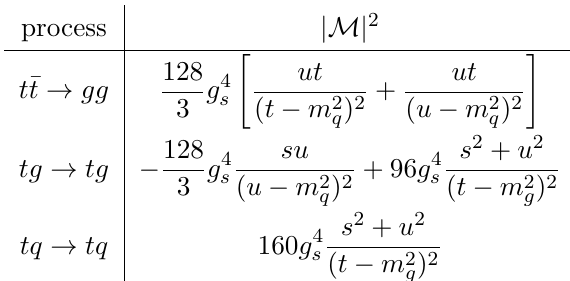
Table 1 . Amplitudes for the scattering processes relevant for the top quark in the leading log approximation. In the tq → tq process we summed over all massless quarks and antiquarks. t-channel